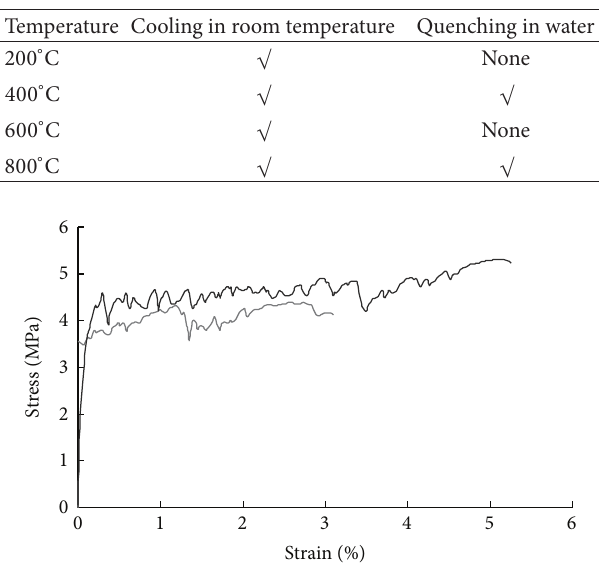
Figure 1: Typical tensile stress-strain response of ECC at 28 days.